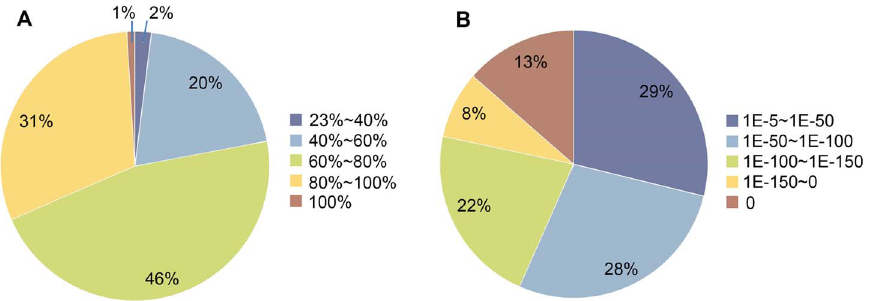
Figure 1. Characterization of broccoli unigenes by searching against public database. A. Identity distribution of unigenes blasted against public databases with E-value cutoff of 1E-5; B. E-value distribution of unigenes blasted against public databases with E-value cutoff of